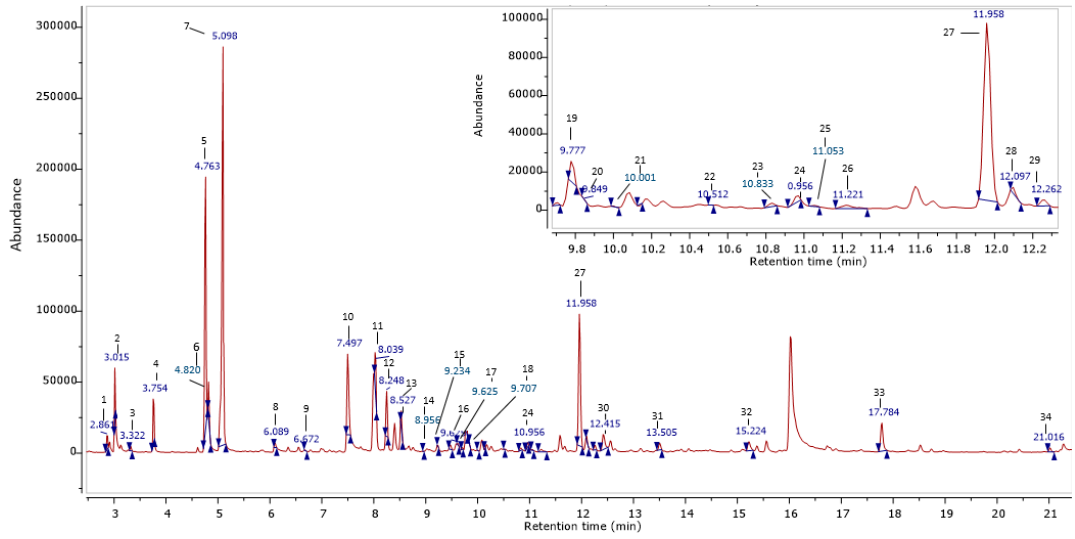
Figure 5. GC–MS chromatogram of fresh S. crispus (for peak identification, see Table 2).